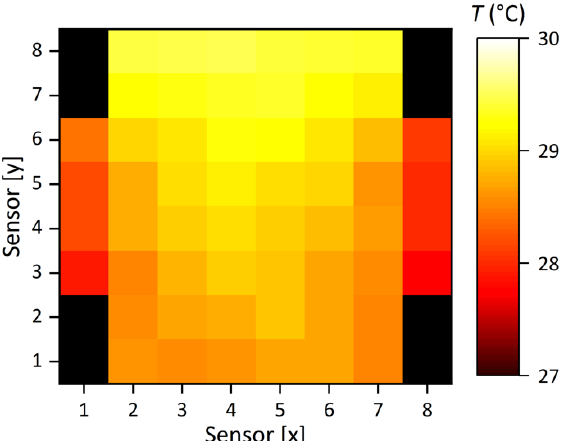
Figure 14. Temperature distribution inside the battery pack between two pouch cells with deac- tivated cooling after discharging with 1 C. At the start, the system had an environment temperature of 22 °C.